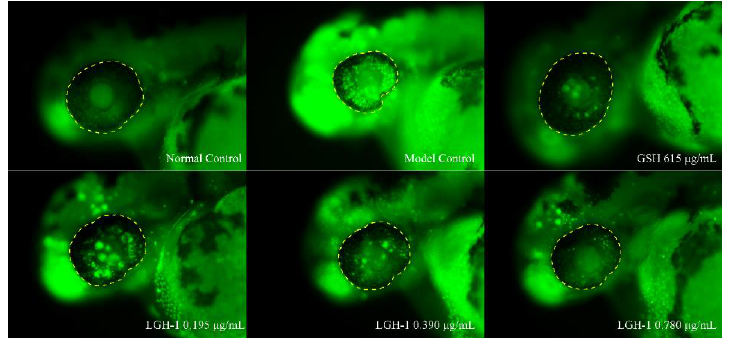
Figure 6. The typical phenotype of apoptotic cells in zebrafish eyes after lutein from G. rubripertincta GH-1 treatment. The yellow dotted line is the analysis site of zebrafish eyes, and the green fluorescent point is apoptotic cells.